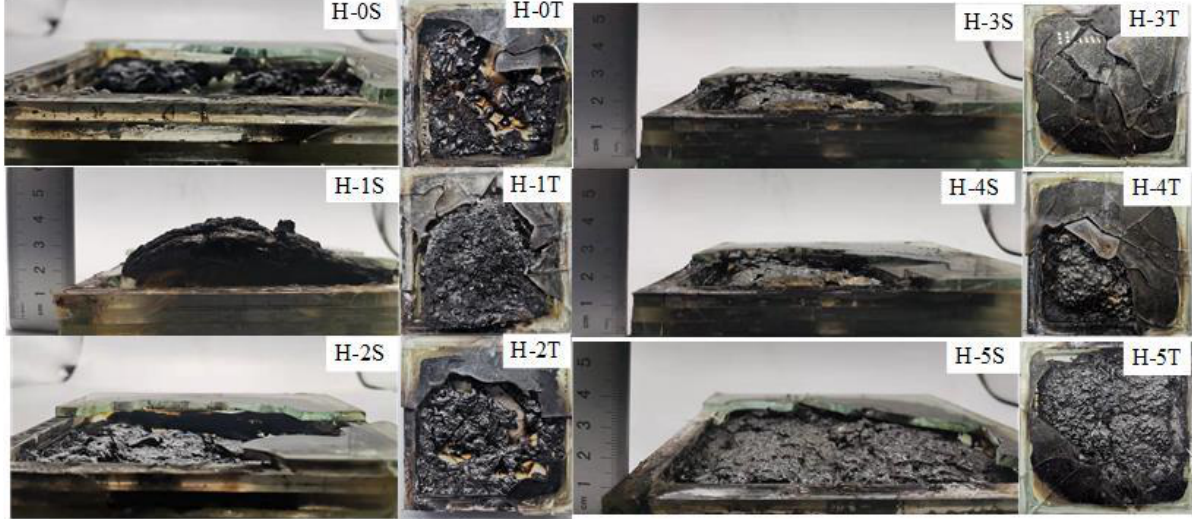
Figure 6. The digital photos of the transparent flame-retarded hydrogels after the heat insulation test (Note: letter S presents the side view of the char, letter T presents the top view of the char).